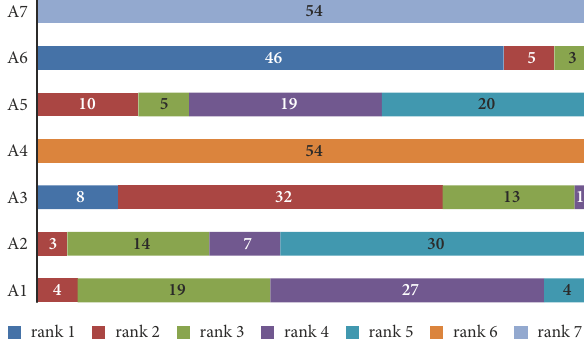
Figure 3. Analysis of the changes in the ranks of the alternatives through 54